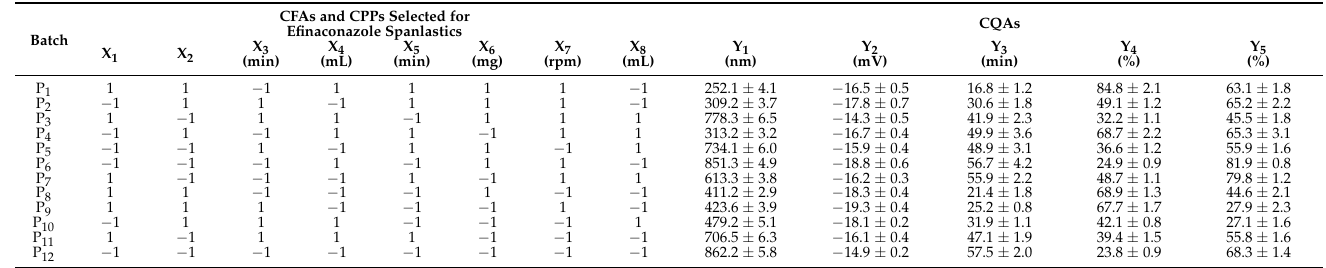
Table 2. The layout of efinaconazole spanlastics displaying the levels of CFAs and CPPs along with observed CQAs (mean ± SD) for all 12 formulation batches of